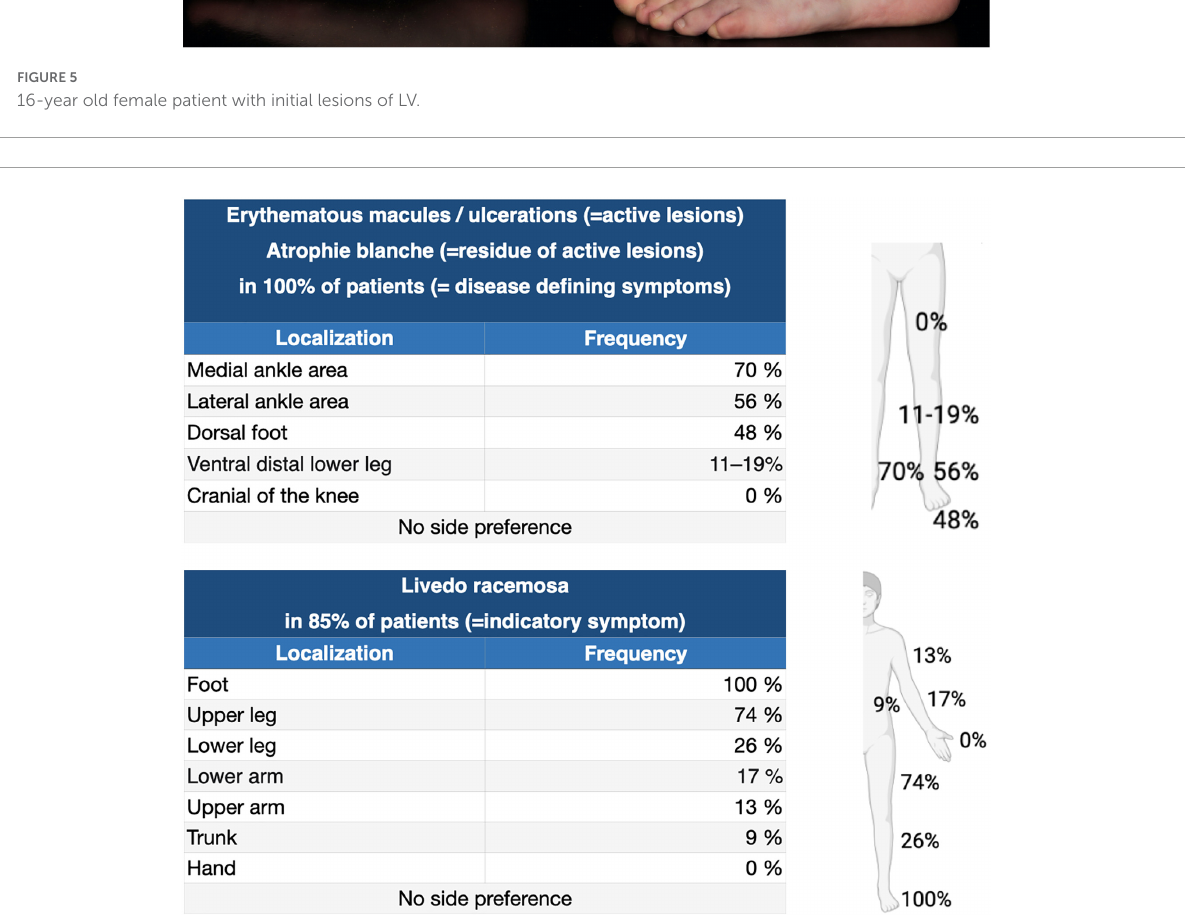
FIGURE6 Clinical presentation of LV. Distribution of clinical symptoms of LV – adapted from Weishaupt et al. (13).